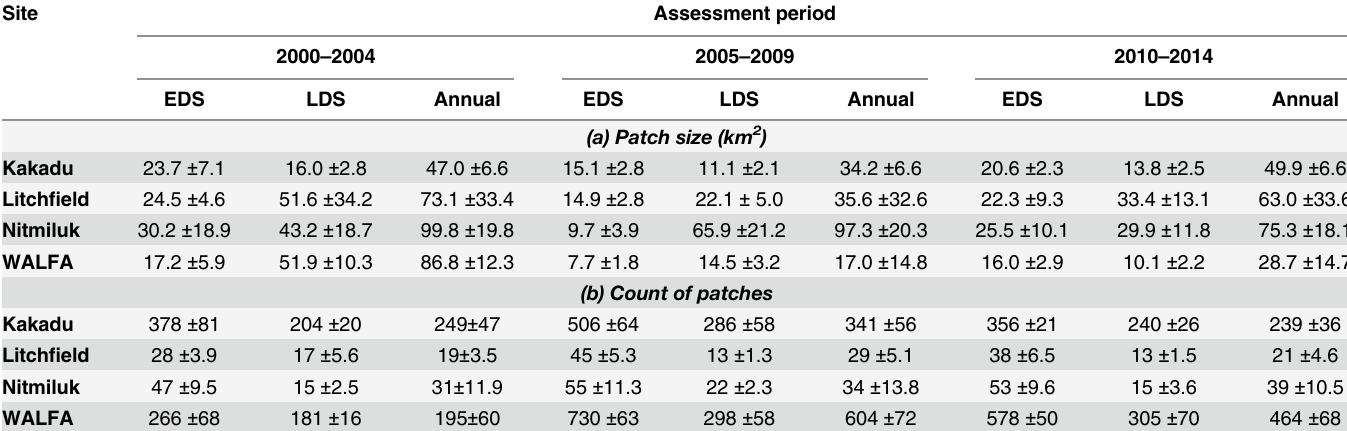
Table 3. Contiguous burnt area (fire patch-size) characteristics ( ± S.E.M.) for study sites over three assessment periods, (a) average fire patch- size, (b) count of patches. EDS = early dry season; LDS = late dry